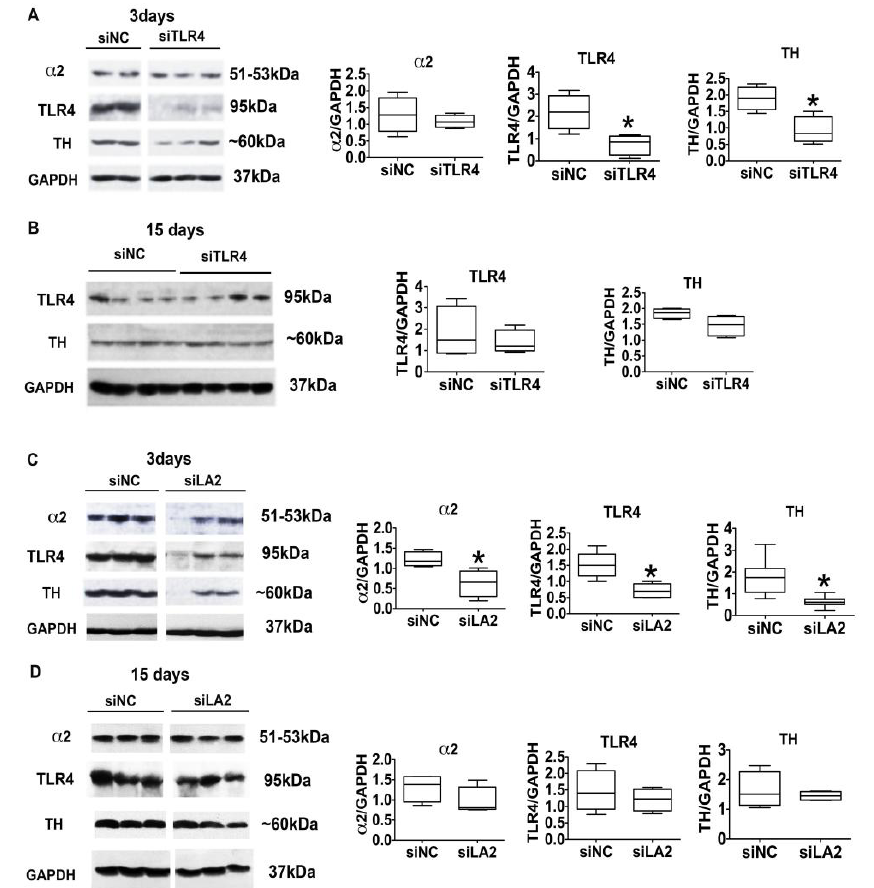
Figure 6. pHSVsiTLR4 and pHSVsiLA2 inhibit TLR4, α 2, and TH expression in the VTA. pHSVsiTLR4 ( A ) and pHSVsiLA2 ( C ) but not pHSVsiNC ( A , C ) inhibit TLR4 and TH expression in the VTA on day 3 post-treatment. pHSVsiLA2 ( C ) inhibits α 2, TLR4 and TH expression on day 3 post infusion (* p ≤ 0.05 by t -test). The expression of TLR4, α 2, and TH is restored to the levels seen in pHSVsiNC-treated animals (innate levels) on day 15 after pHSVsiTLR4 ( B ) or pHSVsiLA2 ( D ) infusion ( p > 0.05 by t -test).